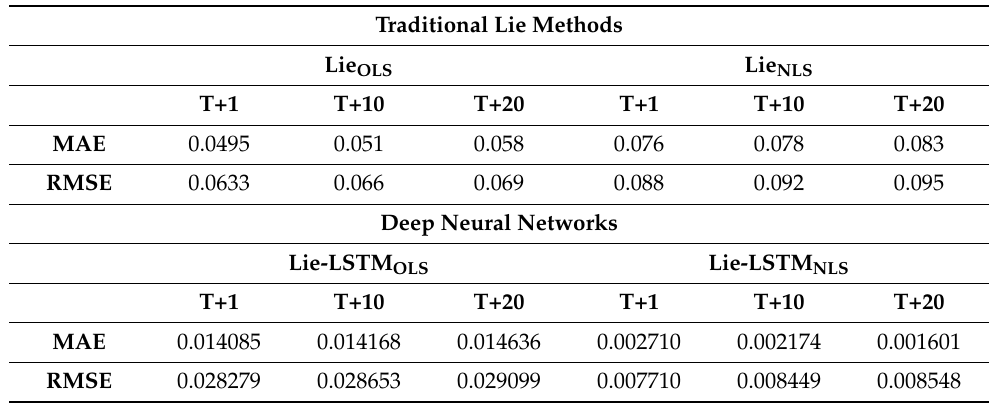
Table 6. The out-of-sample performances of compared methods.